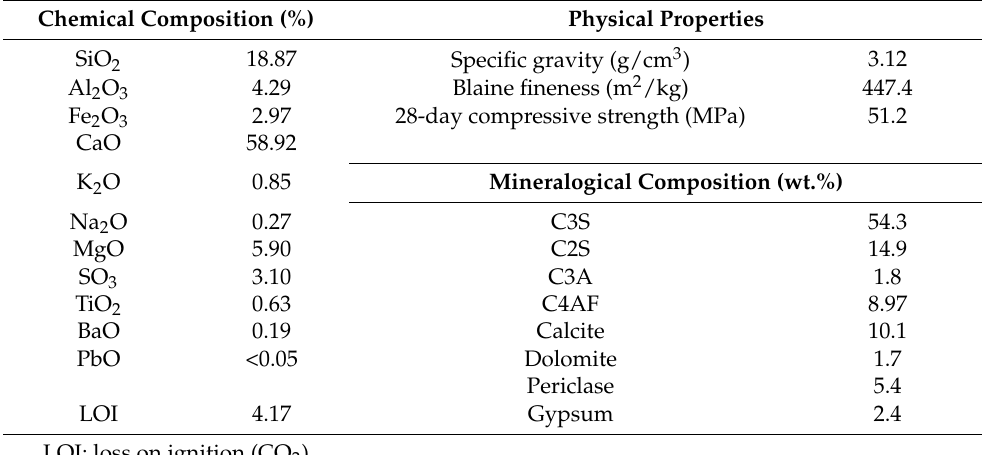
Table 1. Composition and properties of the Portland cement used.